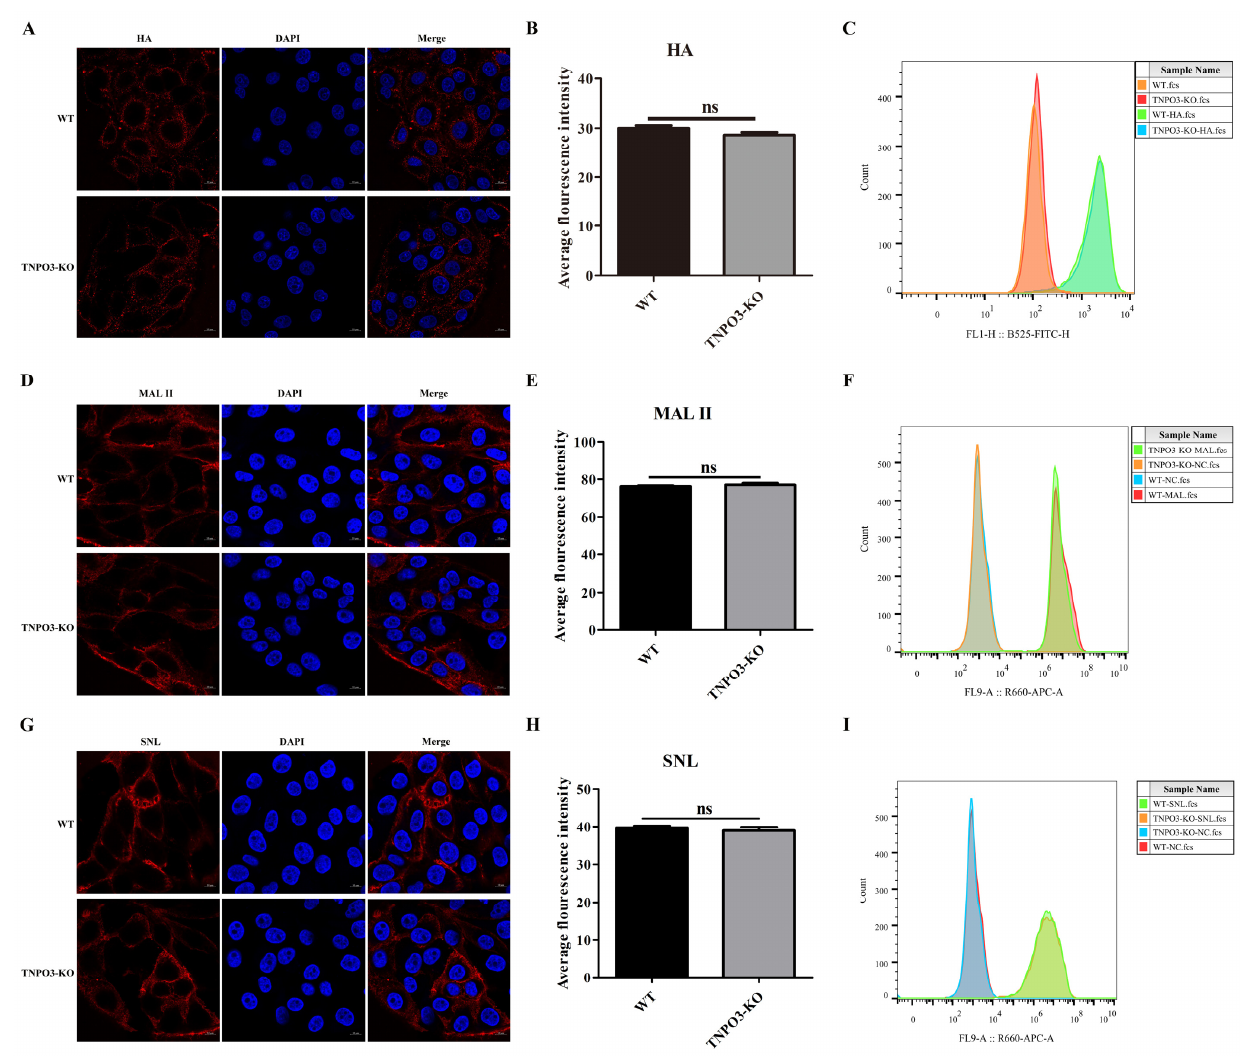
Figure 2. Knockout of TNPO3 does not affect viral attachment and the expression of sialic acid recep- tors. ( A – C ) The efficacy of TNPO3 KO in blocking viral attachment was assessed by an attachment assay. WT and TNPO3-KO cells were infected with HuB strain virus and incubated on ice for 1 h, followed by incubation with anti-influenza virus HA protein antibody. Then, the HA proteins were analyzed by ( A ) confocal microscopy and ( B ) analyzing the average fluorescence intensity of two independent experiments as shown in ( A ) and ( C ) flow cytometry. ( D – F ) Detection of α -2,3 sialic acid expression in WT and TNPO3-KO cells. WT cells and TNPO3-KO cells were incubated with α -2,3-linked sialic acid (MAL II) and then incubated with 10 µ g/mL Cy5 Streptavidin and analyzed by ( D ) confocal microscopy and ( E) analyzing the average fluorescence intensity of two independent experiments as shown in ( D ) or ( F ) flow cytometry. WT and TNPO3-KO were stained with only Cy5-streptavidin, but not treated with lectin. Scale bar = 10 µ m. ( G – I ) Detection of α -2,6 sialic acid expression in WT and TNPO3-KO cells. WT cells and TNPO3-KO cells were incubated with α -2,6-linked sialic acid (SNL) and then incubated with 10 µ g/mL Cy5 Streptavidin and analyzed by ( G ) confocal microscopy and ( H ) analyzing the average fluorescence intensity of two independent experiments as shown in ( G ) or ( I ) flow cytometry. WT and TNPO3-KO were stained with only Cy5-streptavidin, but not treated with lectin. Scale bar = 10 µ